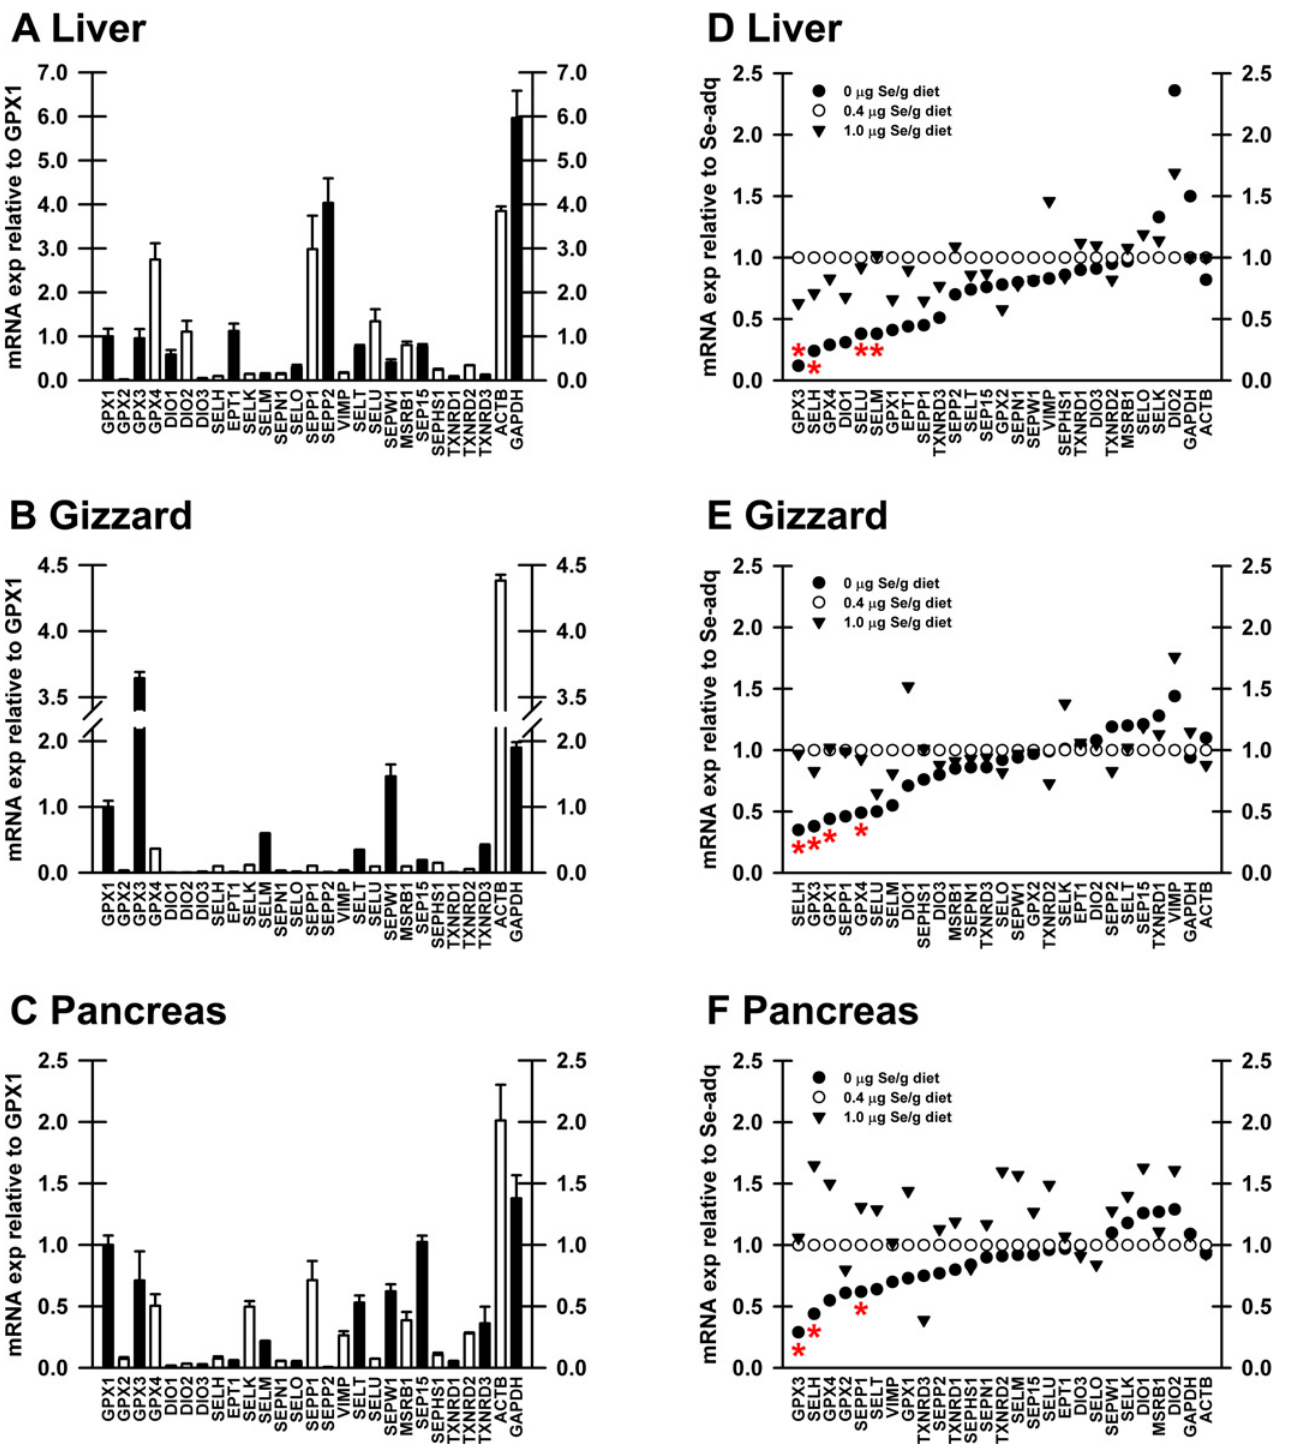
Fig 3. Relative expression of selenoprotein transcripts in liver (A,D), gizzard (B,E) and pancreas (C,F). A-C. Transcript expression for each selenoprotein, relative to GPX1 transcript expression, as described in text. Se-adequate tissues were from poults fed 0.4 μ g Se/g diet. Bars show mean ± SEM (n = 5). D-F. Pooled mRNA from poults supplemented with 0, 0.4 or 1.0 μ g Se/g diet, expressed relative to transcript level in Se-adequate poults (0.4 μ g Se/g diet). Red asterisks indicate significant effect of diet ( P < 0.05), as determined using all 10 Se treatments, as described in text.